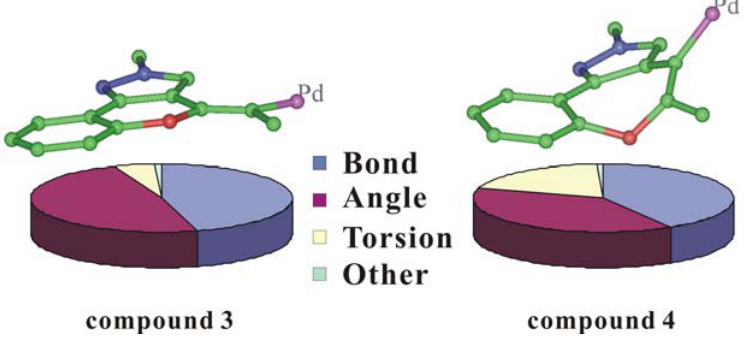
Figure 5. Internal Energy Components and Energy Minimized Structures for Compounds 3 and 4 (some bulky groups and hydrogens were removed from the view for